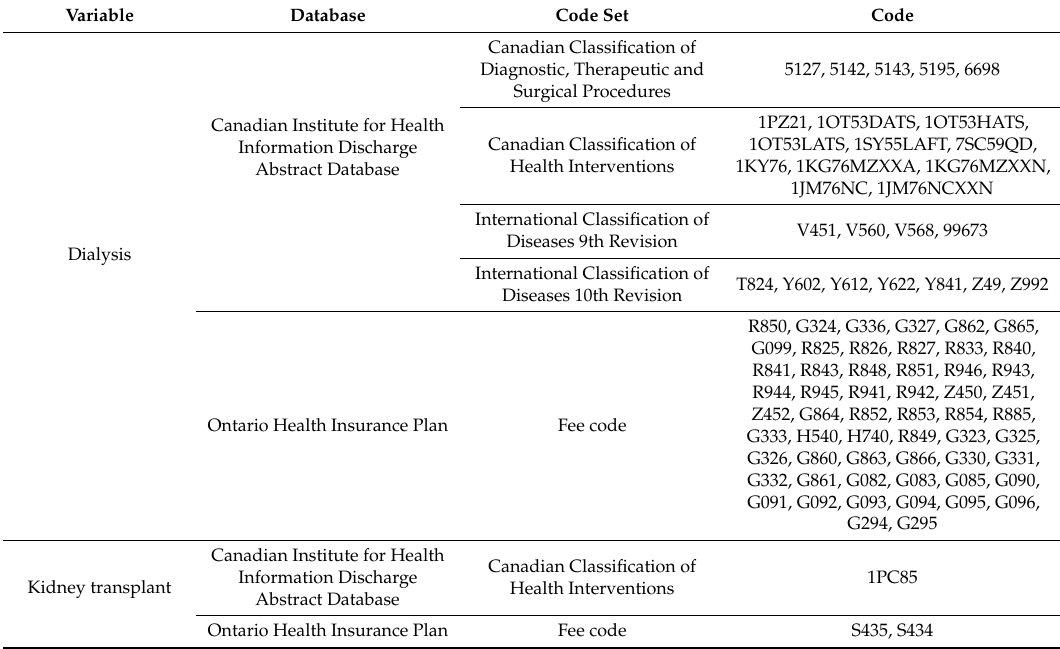
Table A3. Diagnostic codes for exclusion